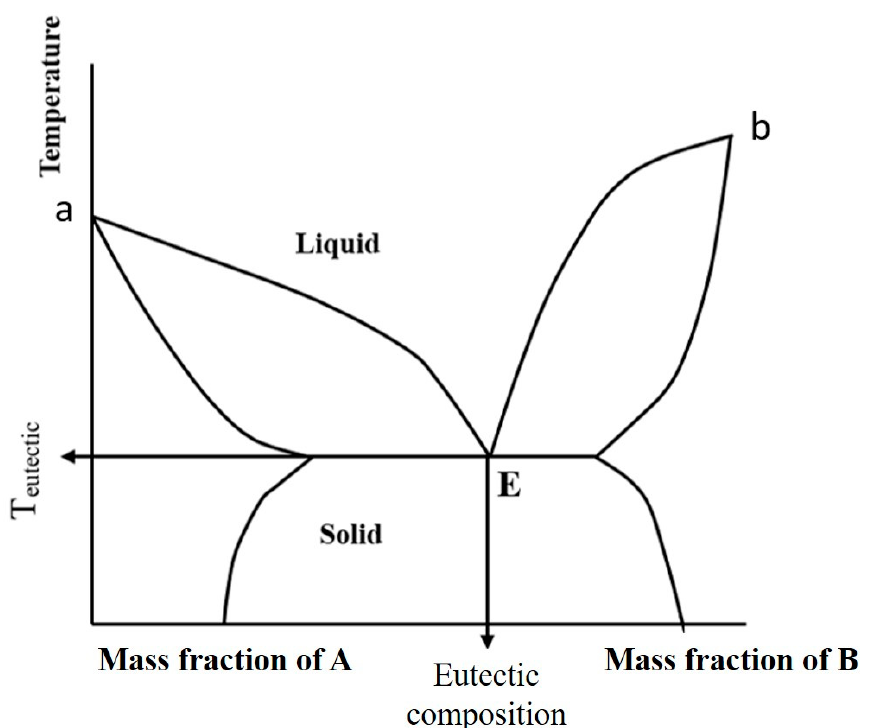
Figure 3. Phase diagram showing the eutectic point, E, and points a and b–the melting points of pure substances, A and B.